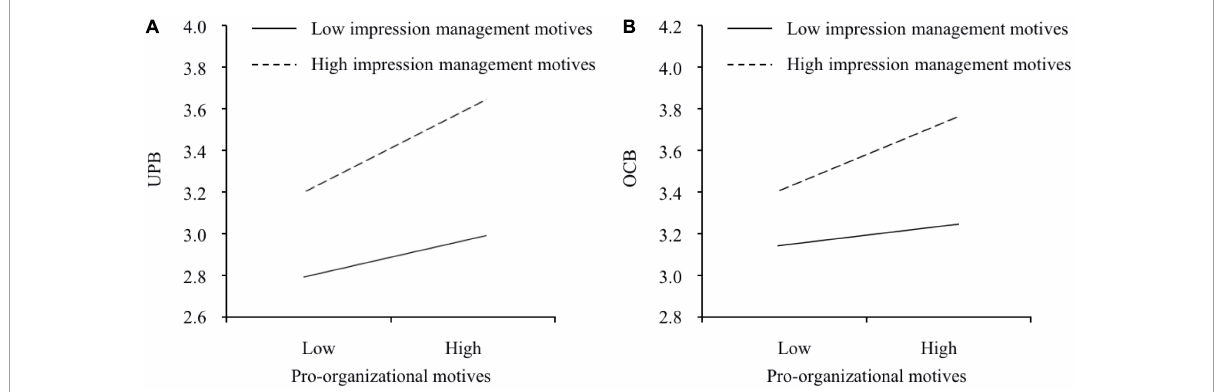
FIGURE3 The moderating effects of impression management motives on (A) the relationship between pro-organizational motives and UPB and (B) the relationship between pro-organizational motives and